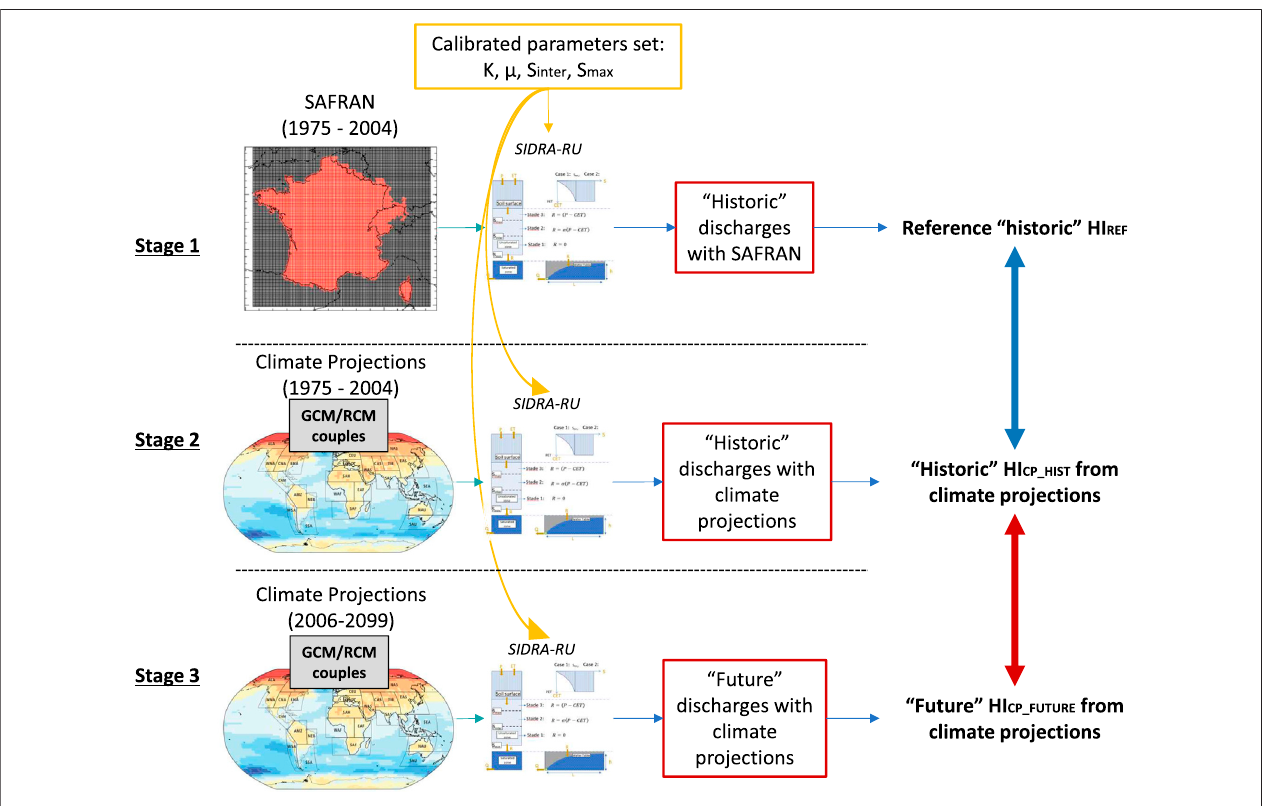
FIGURE 2 | Stages of the modelling strategy. Adapted from Bourgin et al. (2010); IPCC, (2014); Jeantet et al. (2021).